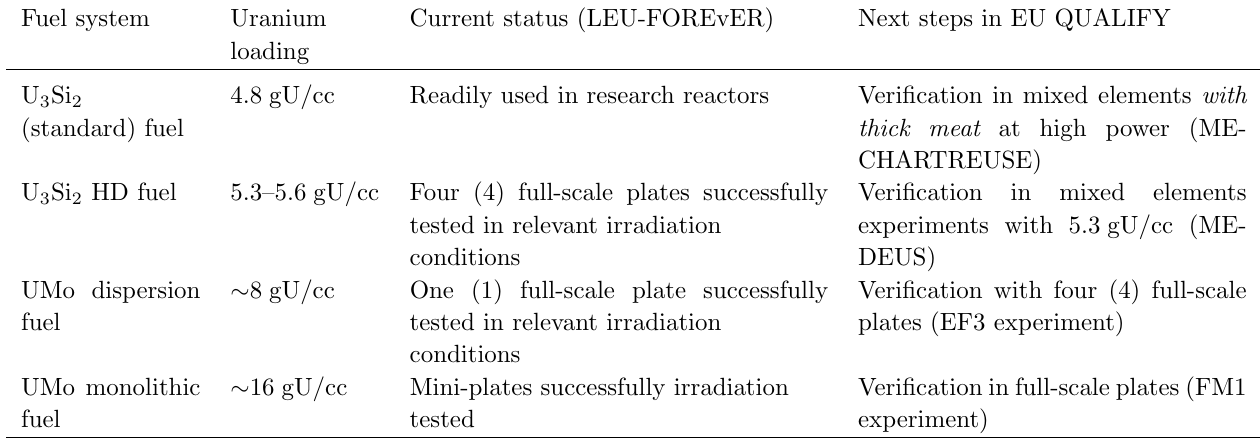
Table 4. Summary of current state-of-the-art and next development steps for the fuel systems studied in this paper. Fuel